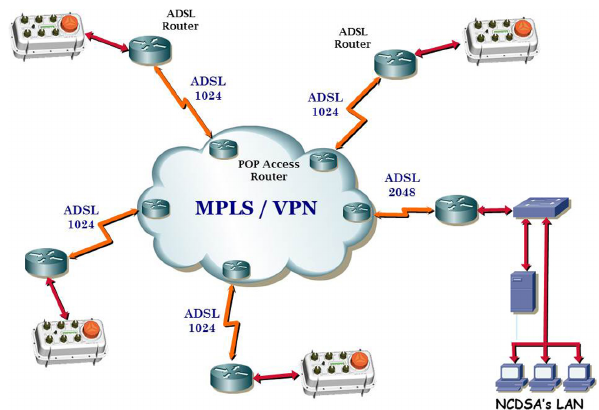
Fig. 4. VSAT satellite topology used by HSNC for remote stations with line-distance from NCDSA more than 200km, or for stations in small isolated isles in South